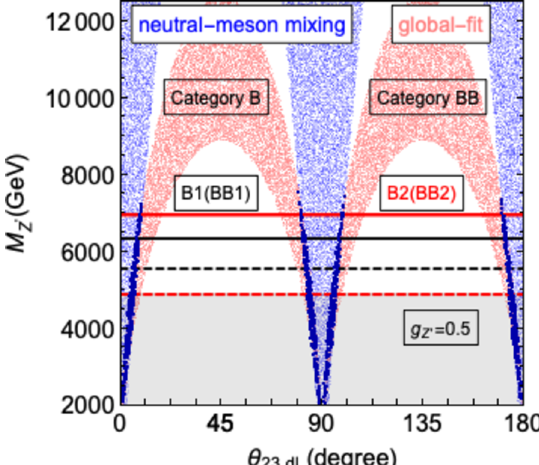
Figure 5 . The constraints in the plane of ( θ 23 ,dL , M Z 0 ) for a fixed value of g Z 0 , for categories B and BB. The pink and blue bands show the 2 σ -allowed regions from the b → s global fit [21] and neutral meson mixing data [30], respectively. The thin dark blue region satisfies the two constraints simultaneously. The regions below the solid (dashed) horizontal lines for scenarios in category B (BB) are excluded to 95 % C.L., with 140 fb − 1 total integrated luminosity, using dimuon searches [33]. The gray band shows the current exclusion for the BB2